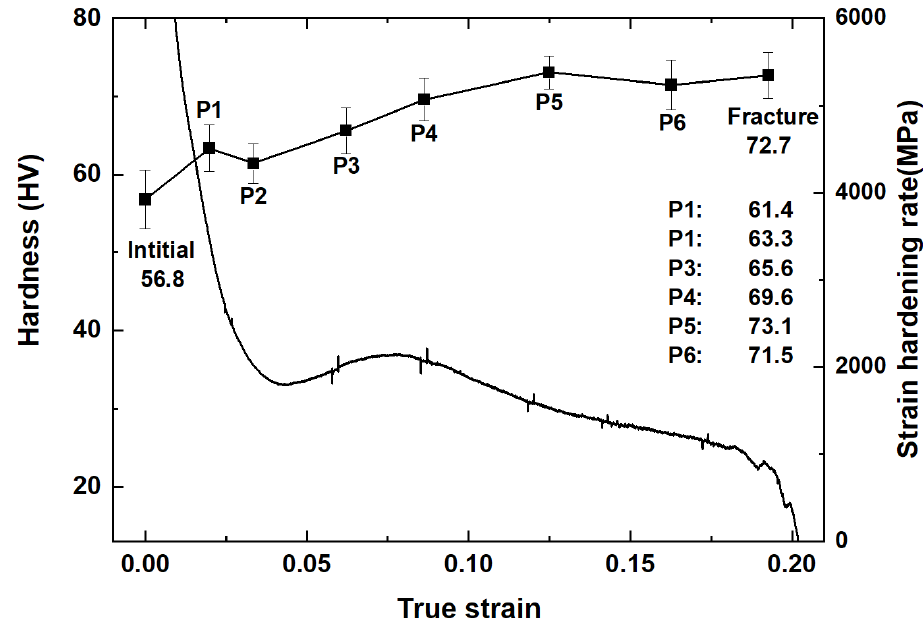
Figure 18. The hardness and strain hardening rate evolution with true strain. The hardness evolution shows a strong relationship with the strain hardening